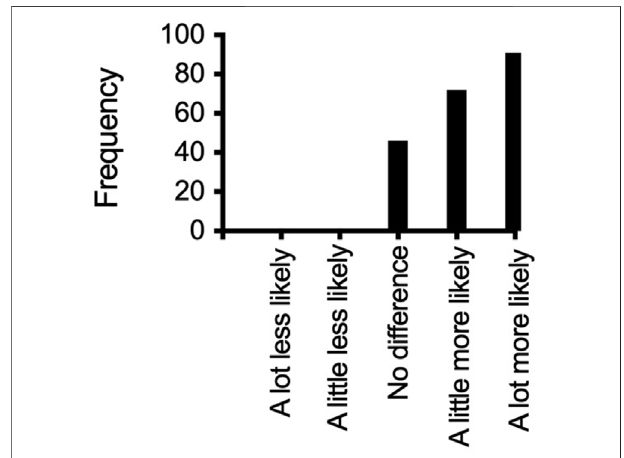
FIGURE 4 | Range of responses to whether a participant was more or less likely to discuss bowel conditions with friends and family because of seeing “ Gut Reaction ”